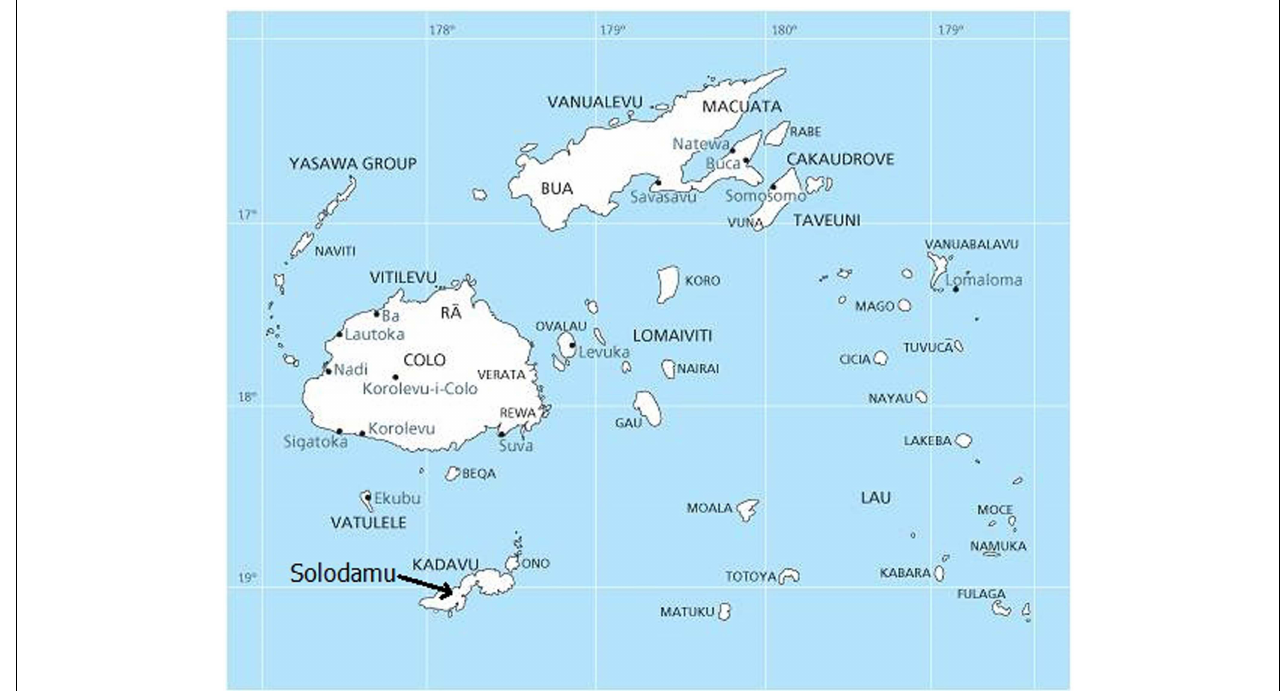
FIGURE 1 | Solodamu location